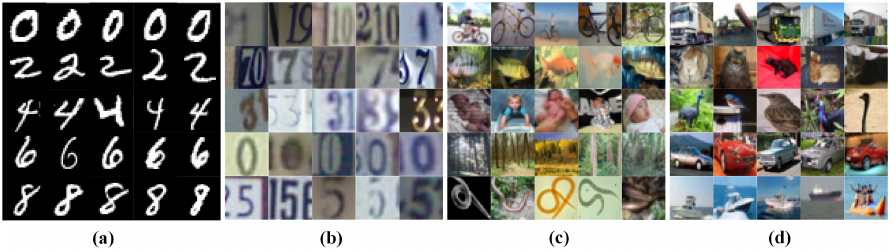
Figure 3. Example images from ( a ) MNIST, ( b ) SVHN, ( c ) CIFAR10, ( d ) CIFAR100 datasets. Only random samples of five classes are shown, and each row corresponds to a different